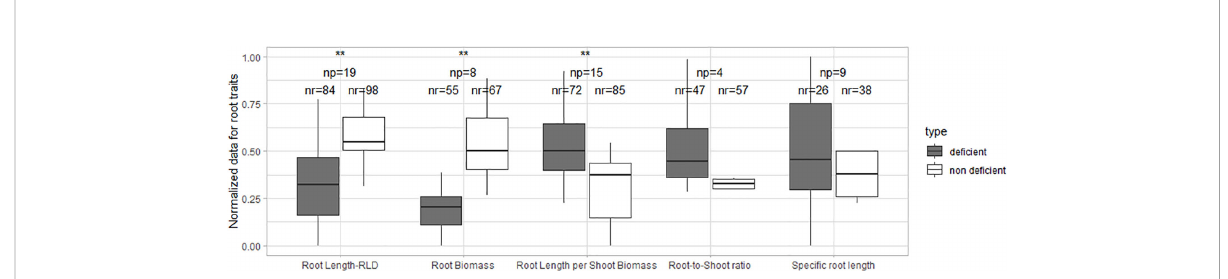
FIGURE 3 Boxplot of the normalized root data under P de fi ciency and P non-de fi ciency. A t-test was performed; ** stands for signi fi cant differences at a 0.95 con fi dence level. np stands for the number of publications/studies considered in the calculation, and nr is the total number of observations within these publications (np).